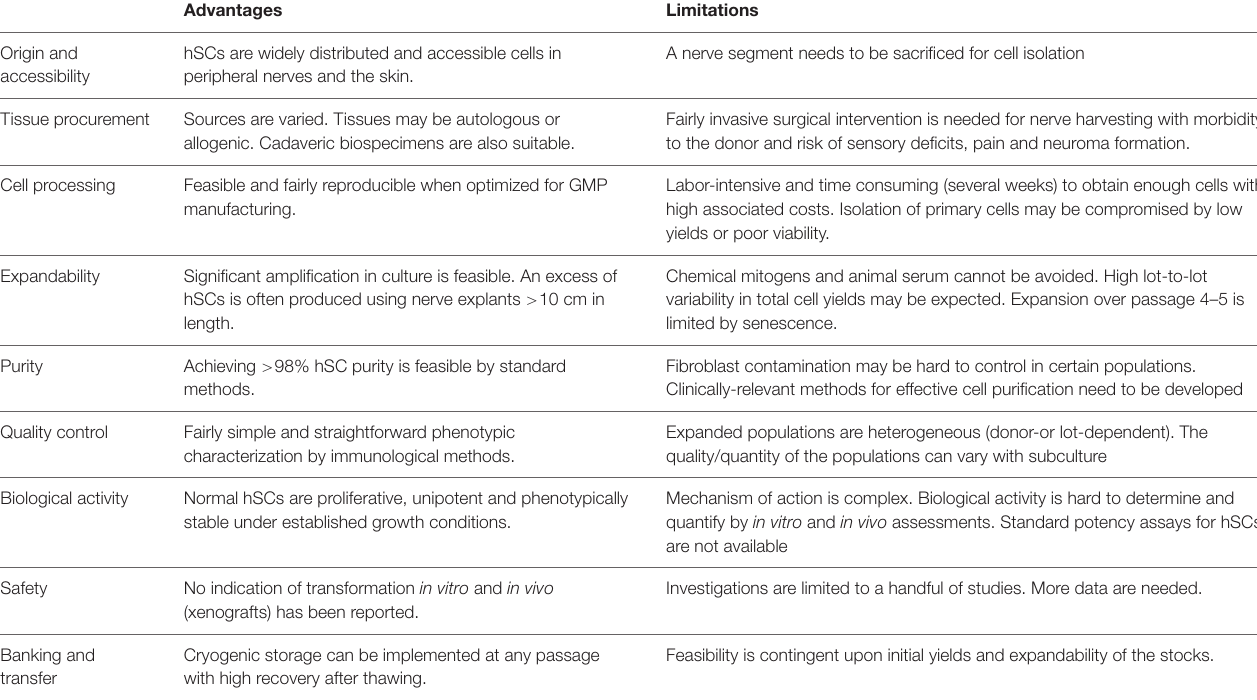
TABLE 1 | Advantages and limitations of cultured hSCs for grafting